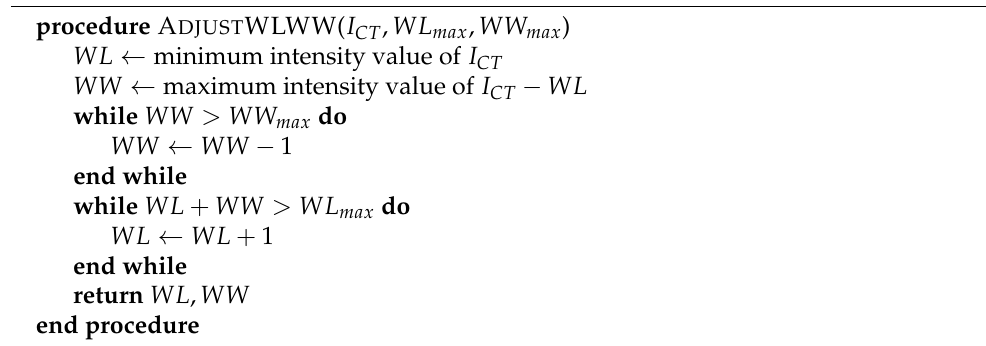
Algorithm 1 Adjusting WL and WW for high-contrast setting in CT